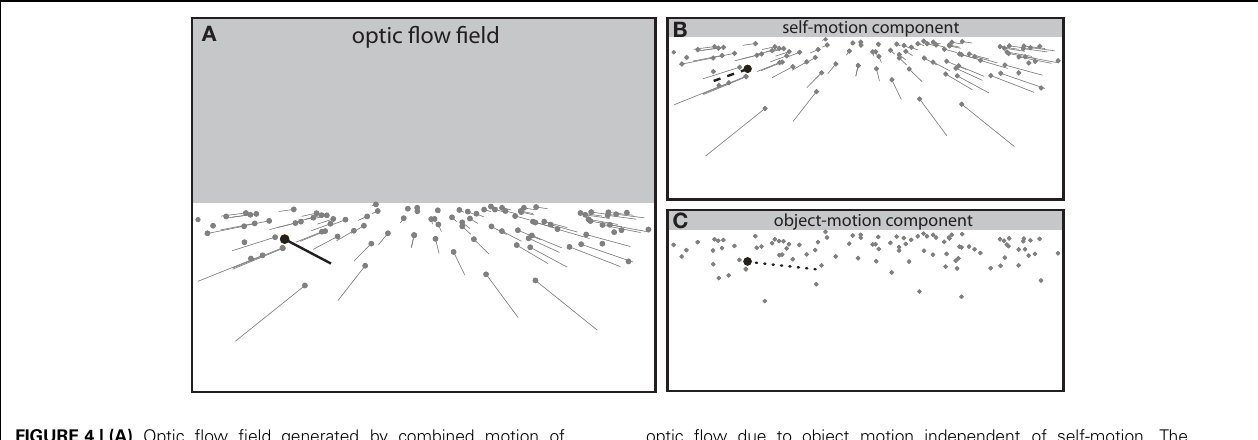
FIGURE 4 | (A) Optic flow field generated by combined motion of observer and object (black dot). (B) The component of optic flow due to self-motion independent of object motion. (C) The component of